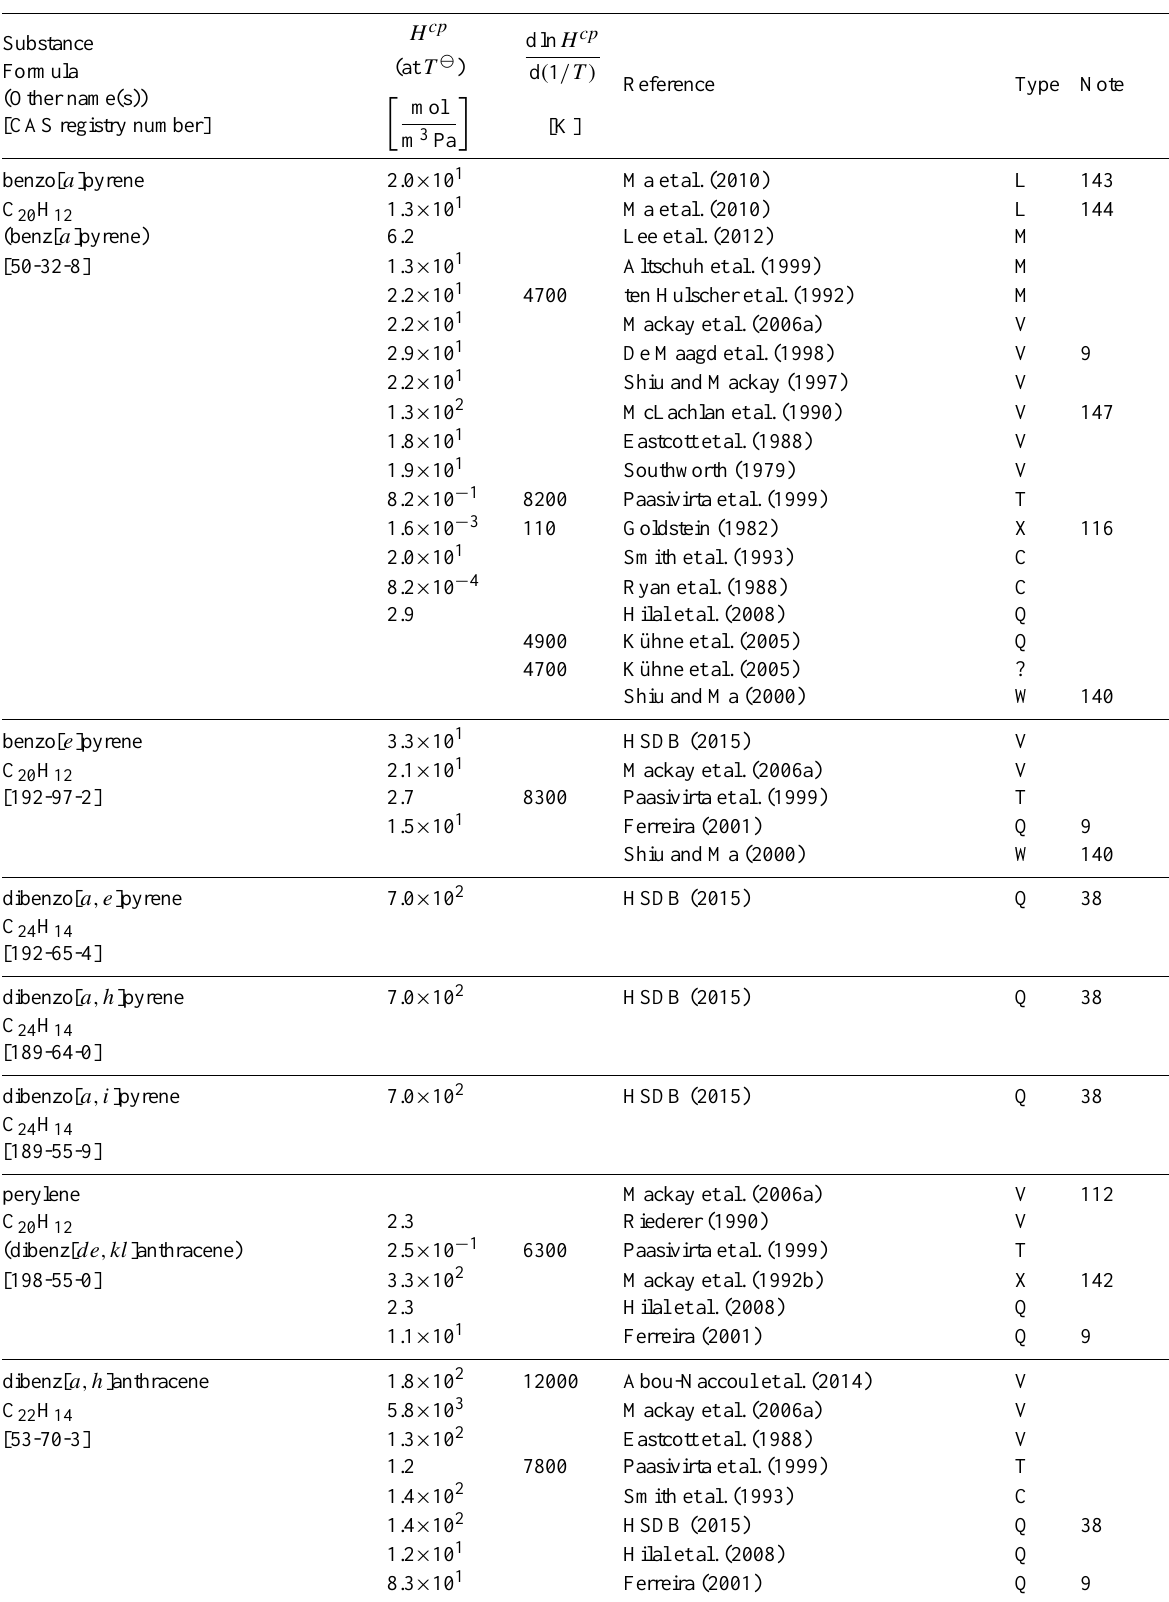
Table 6: Henry’s law constants for water as solvent